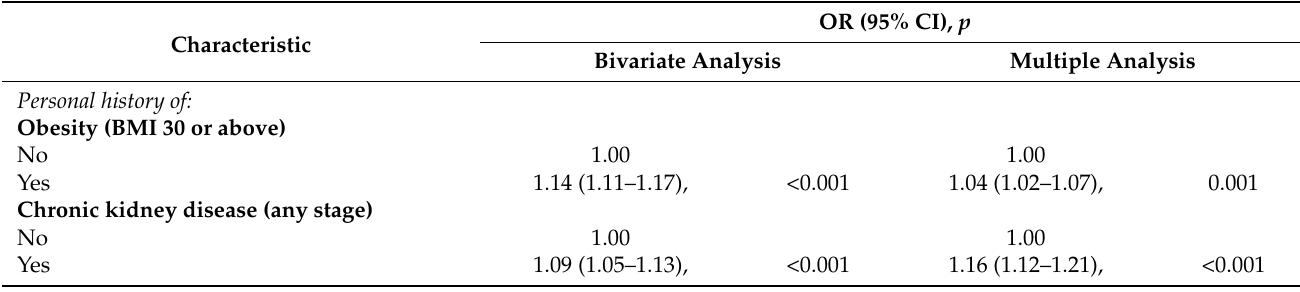
Table 3. Factors associated with the odds of antibiotic prescription at hospital admission due